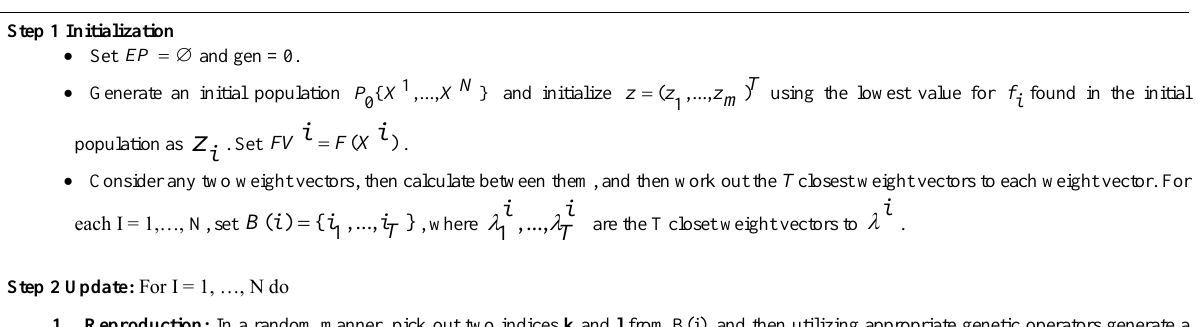
Algorithm 1. The MOEA/D general